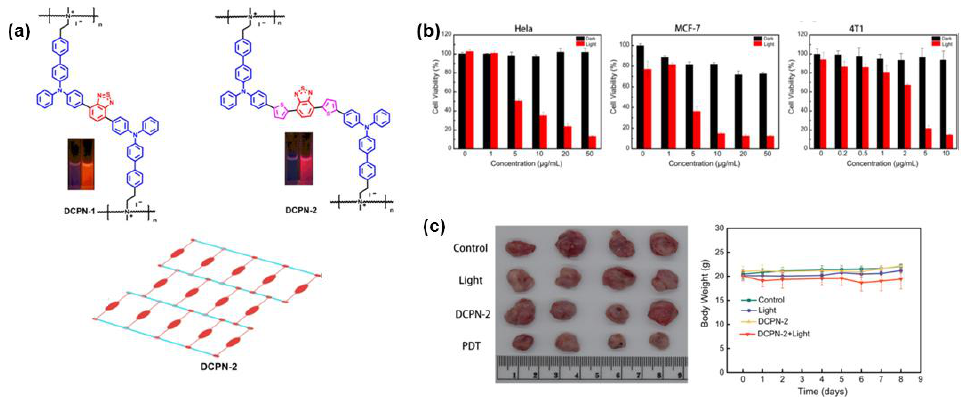
Figure 11. ( a ) The chemical structures of DCPN-1 and DCPN-2. ( b ) The PDT effects based on DCPN- 2 in Hela, MCF-7, and 4T1 cells. ( c ) Photographs of PDT effects for tumors treated with different formulations. Reprinted with permission from Ref. [71]. 2022,